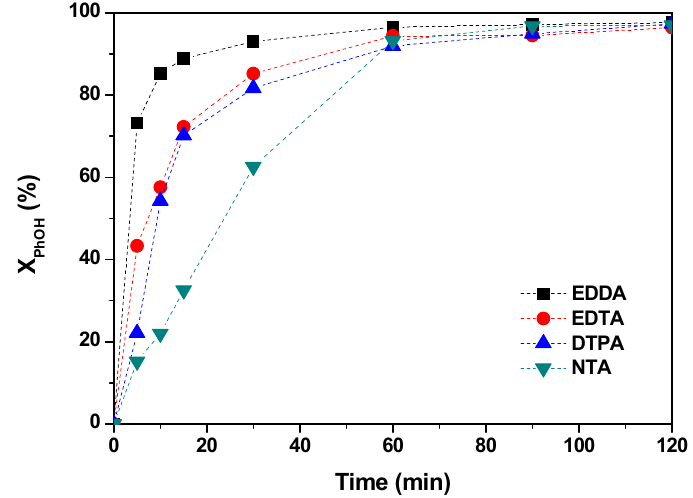
Figure 6. Phenol conversion for different chelating agent. [Phenol] = 1000 mg/L, [H 2 O 2 ] = 5000 mg/L, [Fe 2+ ] 0 = 7 mg/L, T = 30 °C, [pH] 0 = 7.0, L:M = 0.3:1, and t = 120 min.